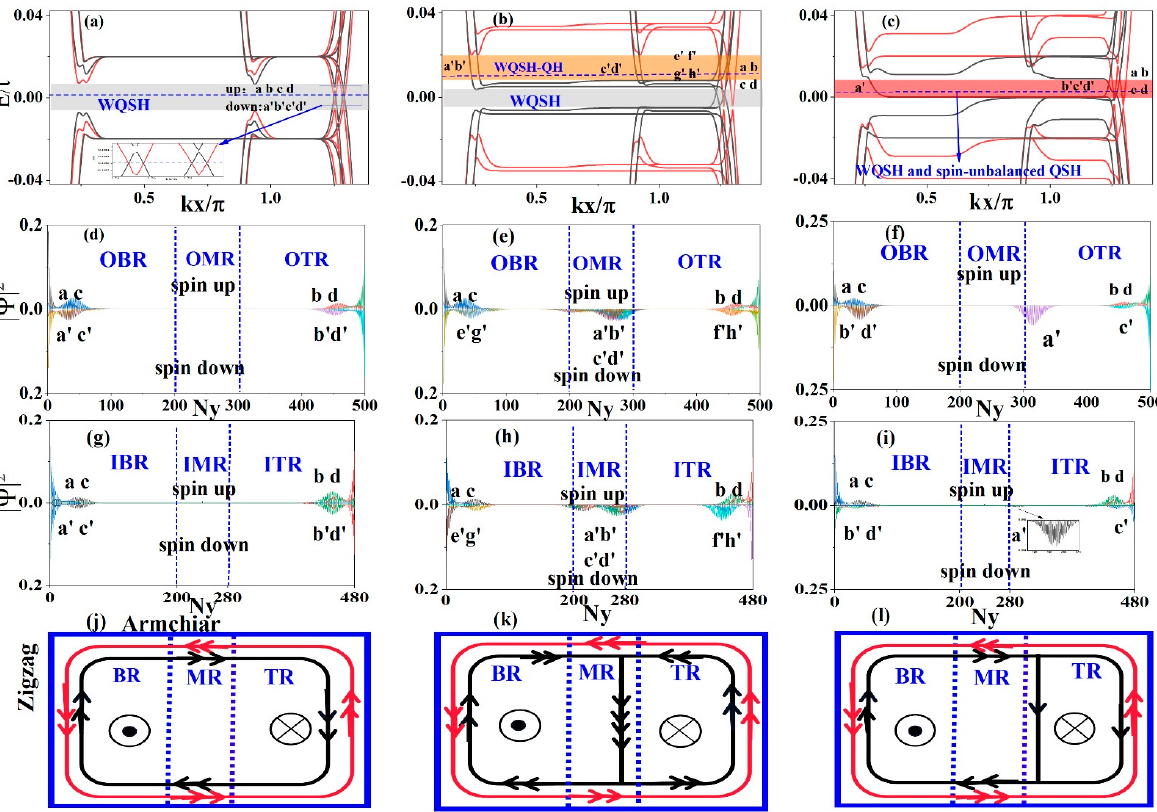
Figure 4. Top panels: Band structure of ZBBGN with ∅ = 0.002 and M = 0.02t for ( a ) E = 0, V 1 = − V 2 = 0; ( b ) E = 8.8 × 10 6 V/m, V 1 = − V 2 = 0; ( c ) E = 0, V 1 = − V 2 = 0.02t. ( d – f ) Second panels: the probability density distributions of edge and interface states of the outer layer indicated by letters in top panels ( a – c ) versus the longitudinal position index Ny. ( g – i ) Third panels: the probability density distributions of edge and interface states of the inner layer indicated by letters in top panels ( a – c ) versus the longitudinal position index Ny. ( j – l ) Bottom panels: schematic diagrams of edge-state propagation (the direction indicate-d by arrows), corresponding to the edge states marked with letters in the top panels ( a – c ). The red (black) lines with arrows represent spin-up (spin-down) states. When both the fixed electric field E = 8.8 × 10 6 V/m and Zeeman splitting M =